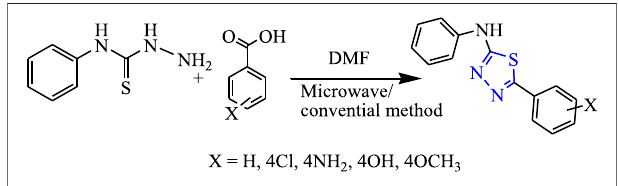
Frontiers in Chemistry |